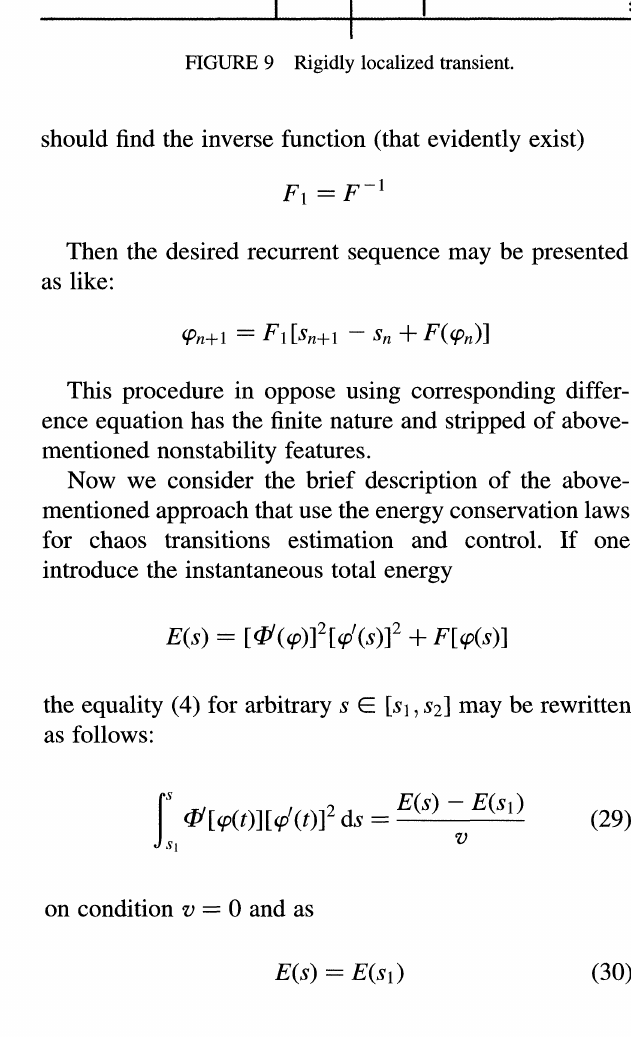
FIGURE 9 Rigidly localized